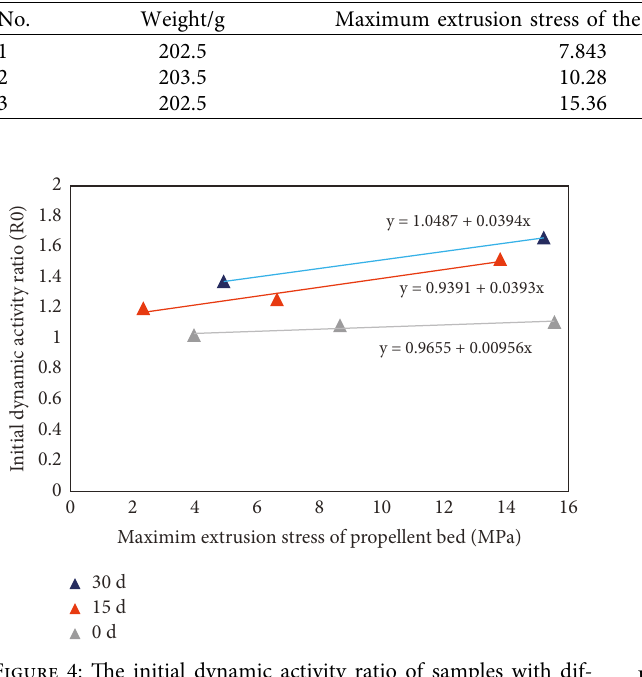
Table 7: Test data of the initial dynamic activity ratio of samples aged for 30